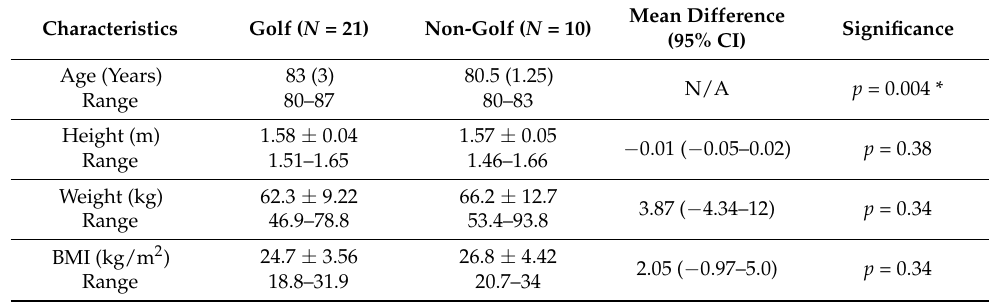
Table 1. Participant characteristics: Age is presented as median (interquartile range). Height, weight, and body mass index (BMI) are presented as mean ± SD with mean difference (confidence intervals).